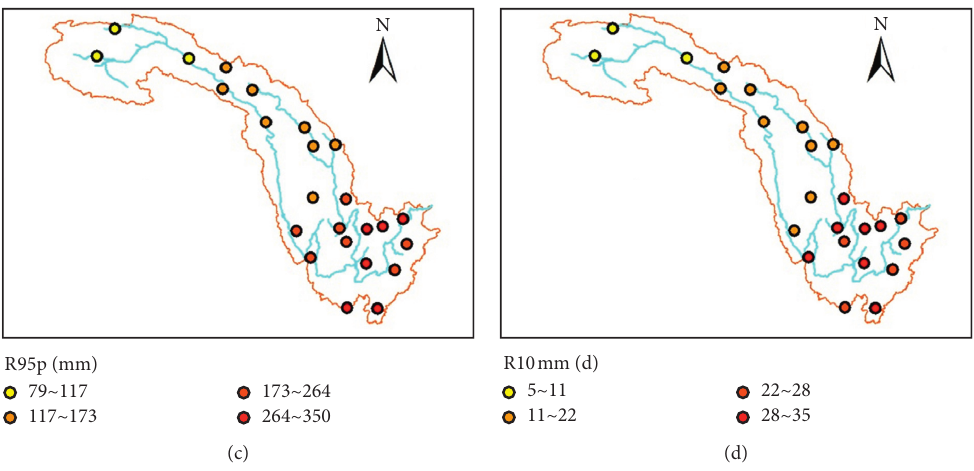
Figure 4: Spatial distributions of extreme precipitation indices in the JRB. Table 6: Mean values of extreme precipitation indices in the four subregions of the JRB. Subregions